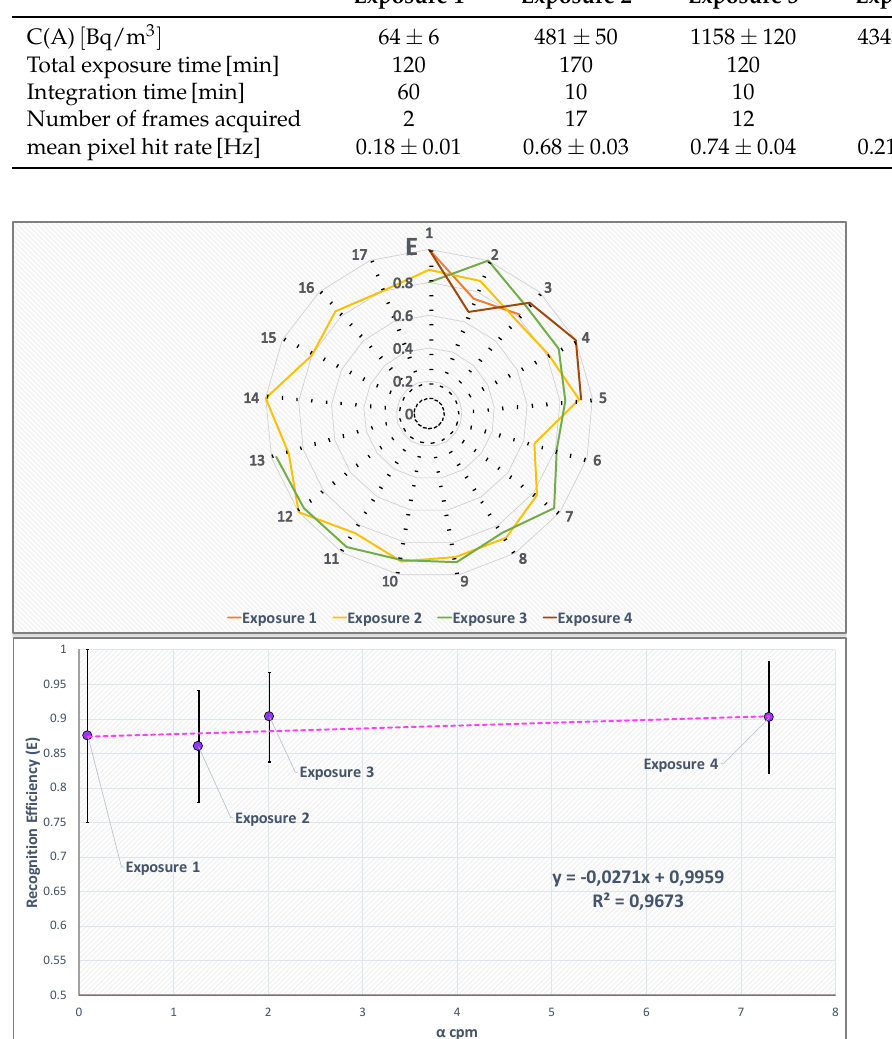
Figure 7. Upper canvas: Recognition efficiency values evaluated according to Equation (4) for the single measurements ( x -axis shows the number of measurement, y -axis the algorithm recognition efficiency E) performed at different radon activity concentration values (different line colors). Lower canvas: mean recognition efficiency value for each exposure versus the mean α counts per minute detected by the